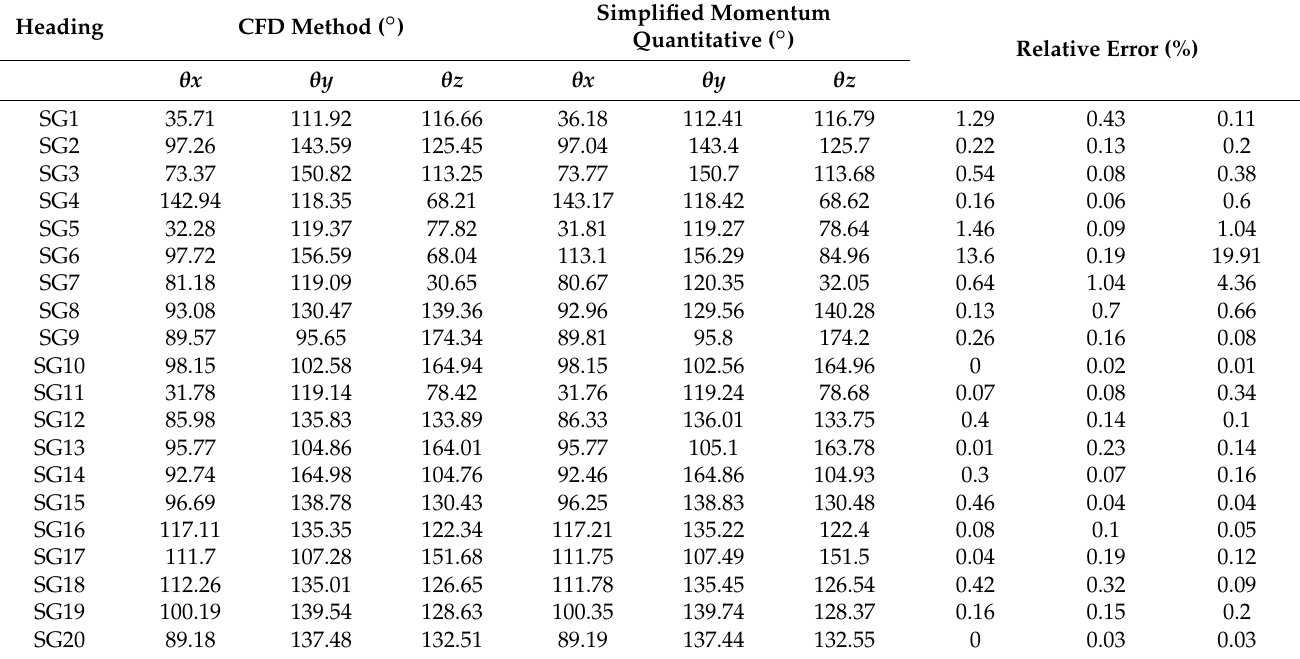
Table 2. The CFD method and simplified momentum quantitative used to calculate the displacement force angle.